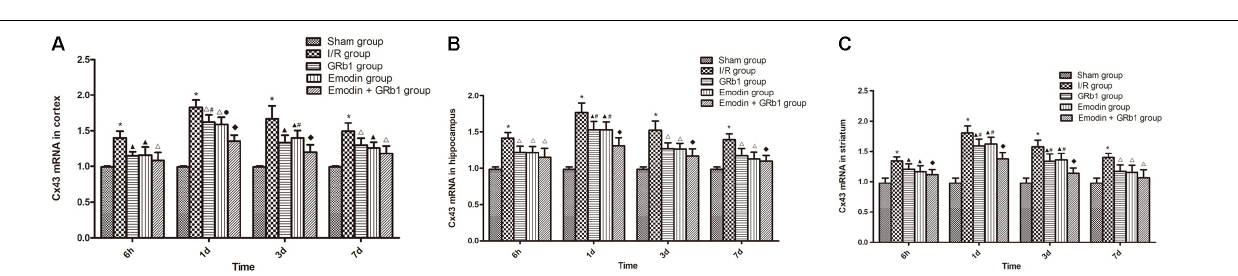
FIGURE 7 | The Cx43 mRNA expression in different groups after I/R in rats (mean ± SD, n = 5). (A) Cortex; (B) hippocampus; (C) striatum. Quantitative analysis for the results of groups at 6 h, 24 h, 3d, and 7d, respectively. One-way analysis of variance (ANOVA) was used for multiple group experiments comparisons and followed by Dunnett test for comparison of two groups within the multiple groups. ∗ p < 0.05, compared with Sham group. ∗ p < 0.001, compared with Sham group. (cid:78) p < 0.05, (cid:77) p < 0.01, (cid:7) p < 0.001, compared with I/R group. • p < 0.01, compared with the Emodin+GRb1